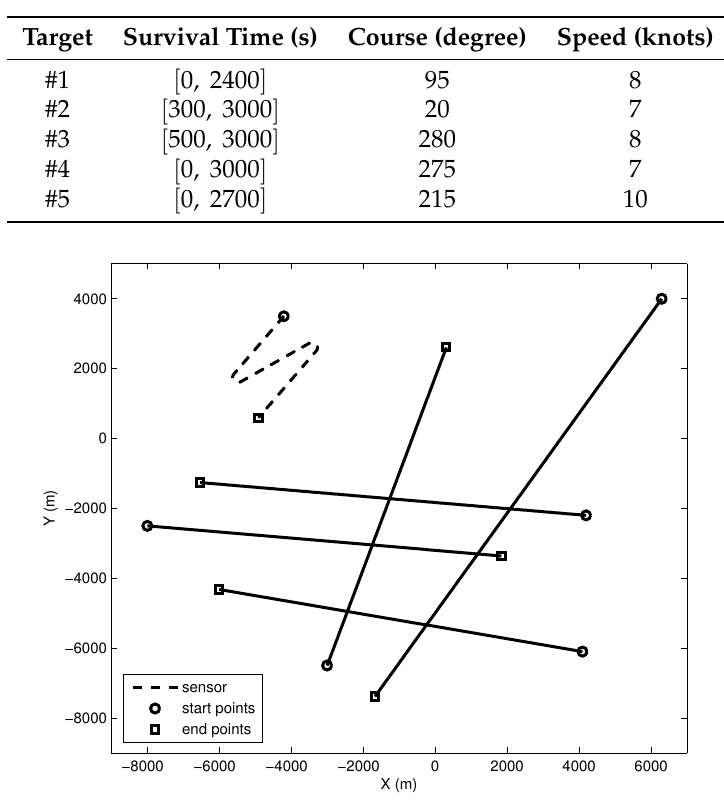
Table 1. Motion profile of targets.